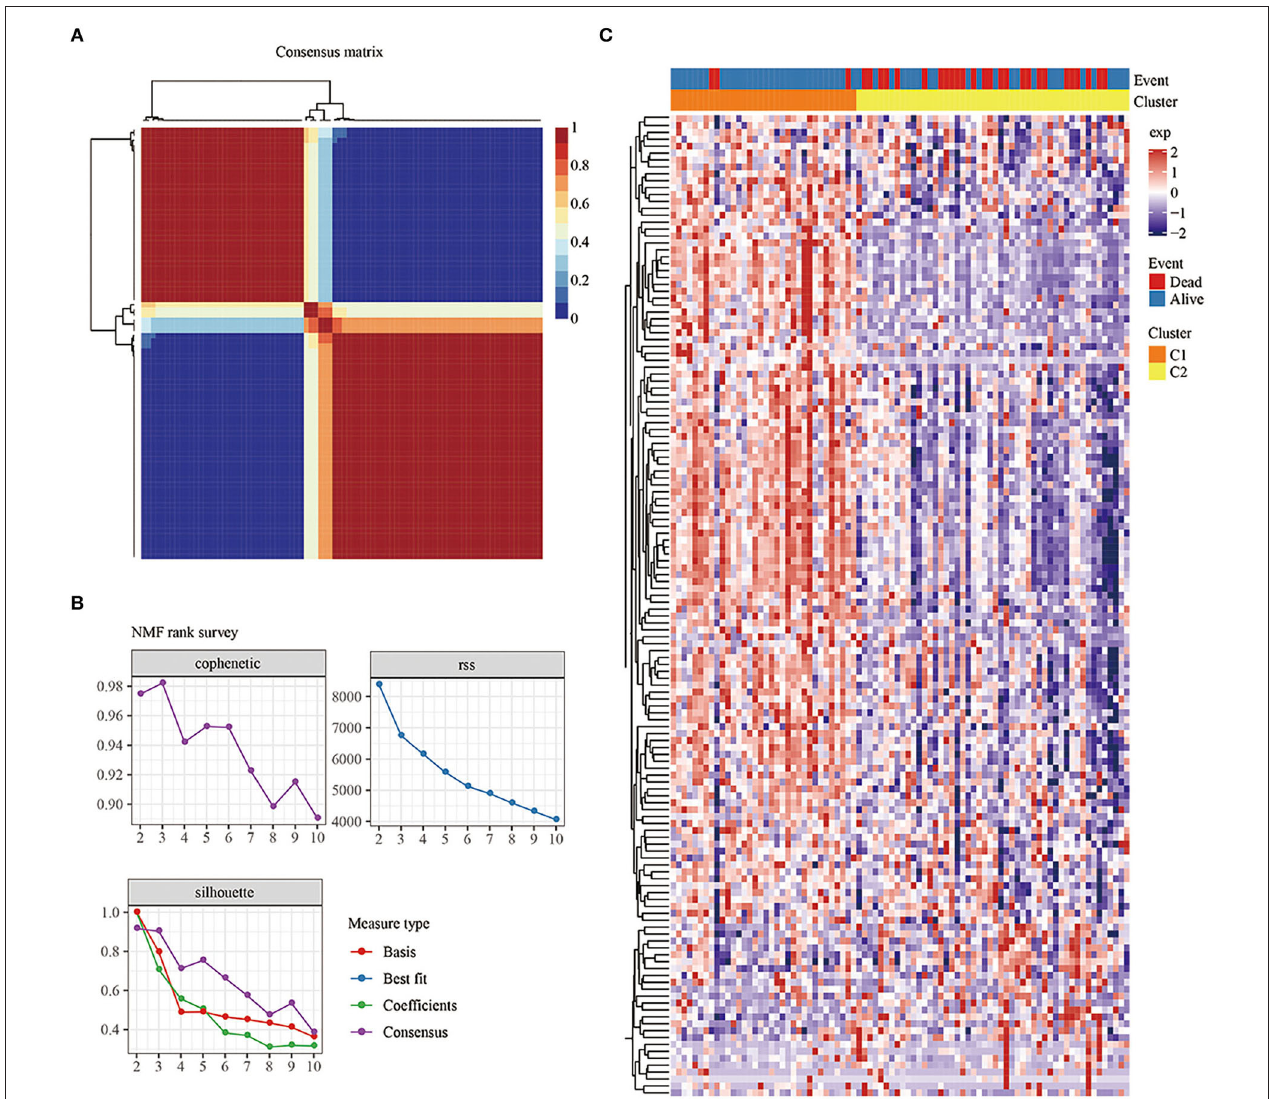
FIGURE 2 | (A) : Consensus map of NMF clustering. (B) Cophenetic, rss, and dispersion distributions with ranks from 2 to 10. Cophenetic correlation is obtained based on the concordance matrix proposed by Brunet et al. and it is used to reflect the stability of the clusters obtained from NMF. The value of cophenetic correlation is between 0 and 1, and the larger the value, the more stable the clusters. The rss refers to the residual sum of squares, which is used to reflect the clustering performance of the model. The smaller the value, the better the clustering performance of the model. Theoretically, this value is the smallest when each sample is clustered into 1 class, but such results are not available in practice, so it needs to be used in combination with other indicators. (C) Heat map of the expression of the prognosis-related genes in the different